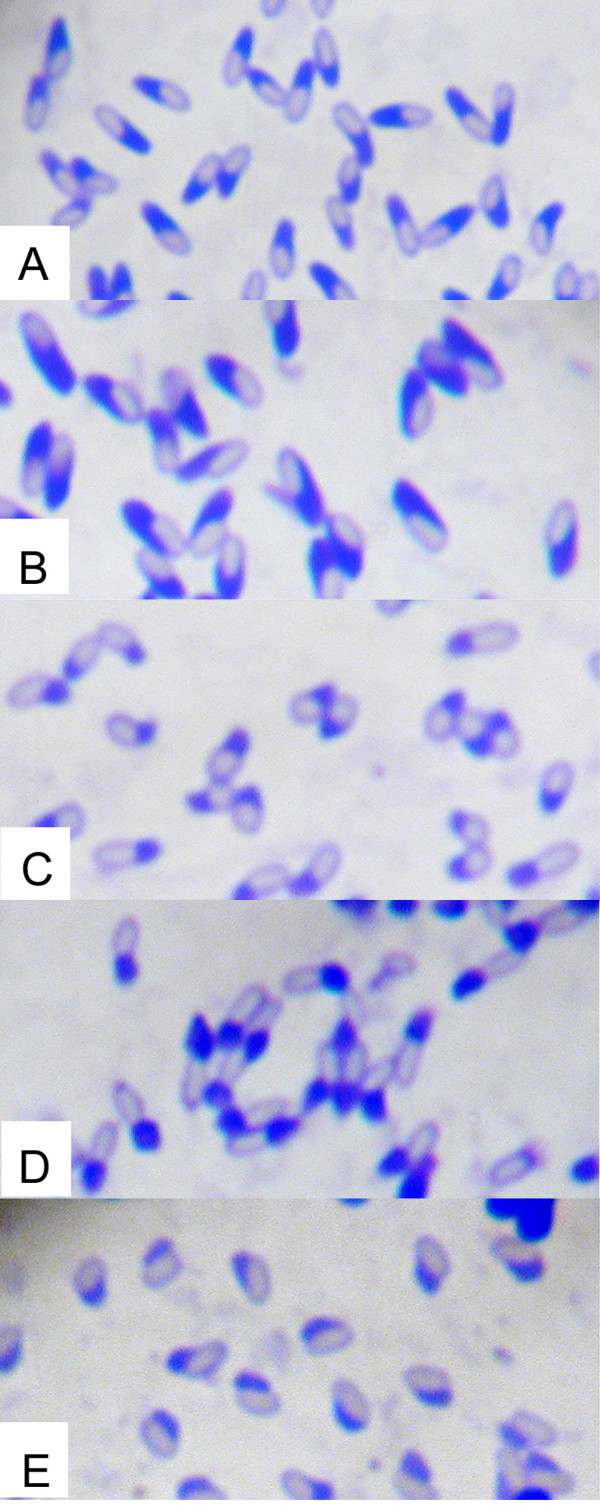
Examples of the "capped" spore morphology. Dark blue "caps" attached to lighter staining spores. A) Bt2-2, B) Bt1-48, C) Bt2-56, D) Bt1-46 and E) Bt2-14.